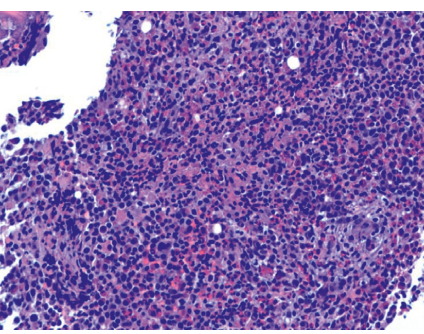
Figure 1: Area of hypercellular bone marrow with red cell